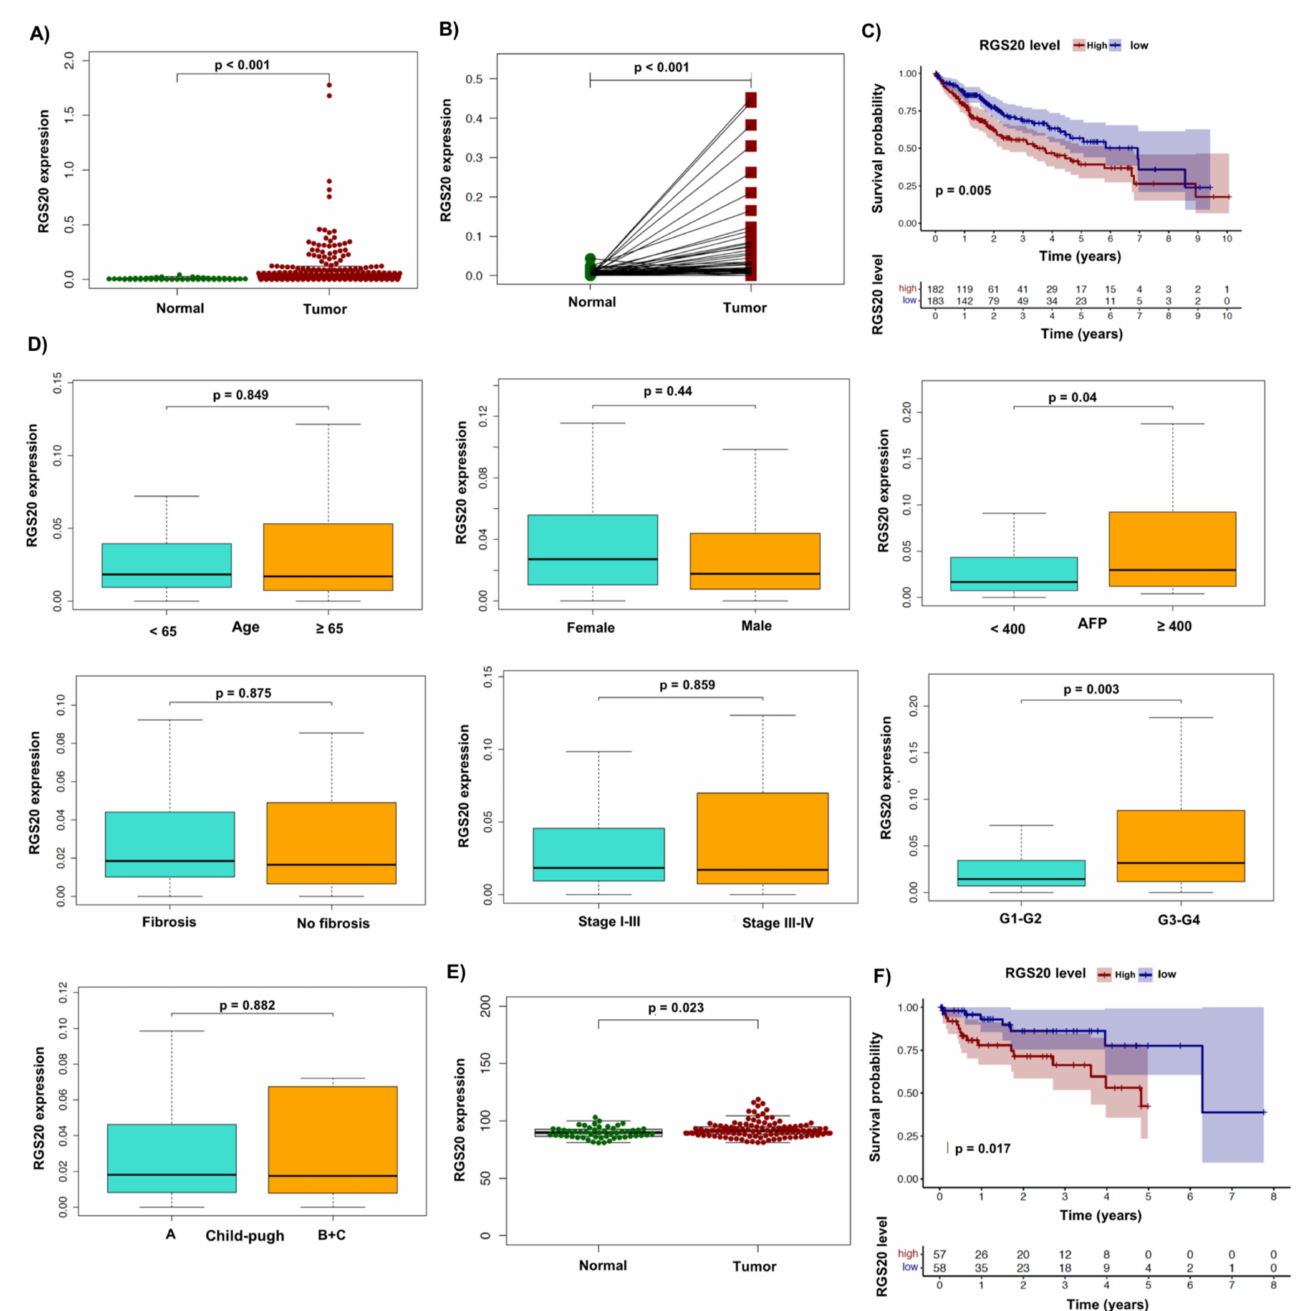
Figure 1. RGS20 analysis in HCC patients (TCGA and GEO analysis). ( A ) All samples, ( B ) and paired samples from TCGA data were analyzed using Wilcoxon Rank Sum test. ( C ) The impact of RGS20 expression level on overall survival time in HCC patients calculated using Kaplan–Meier